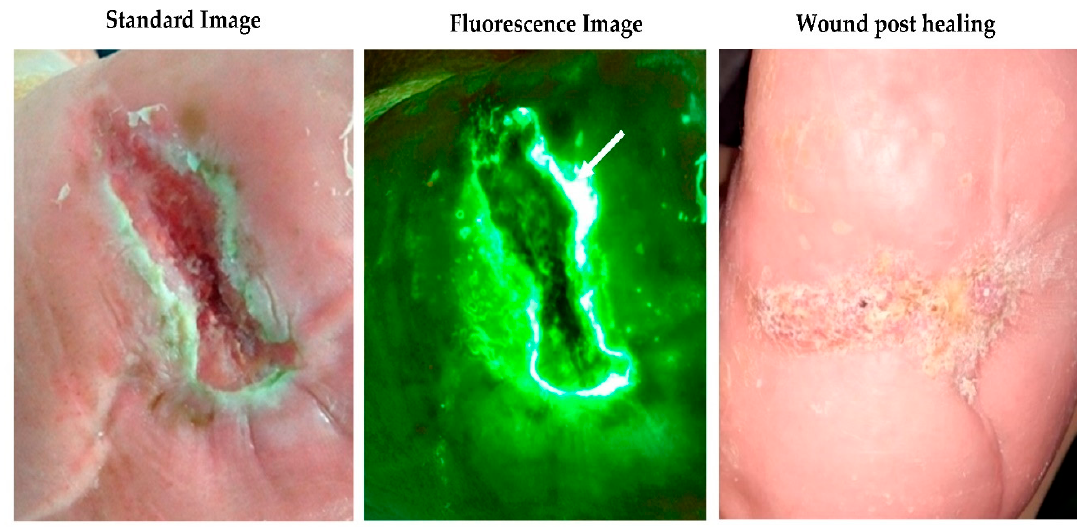
Figure 1. Cyan fluorescing bacterium (white arrows) indicating Pseudomonas aeruginosa on a diabetes foot ulcer overlying a midfoot Charcot foot deformity with subsequent standard imaging showing the wound fully healed 12 weeks later.